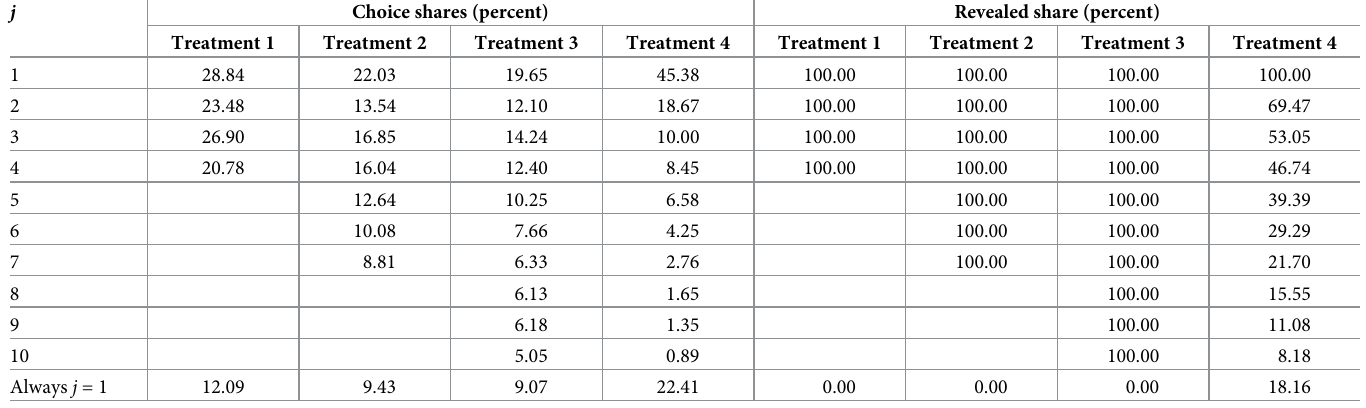
Table 3. Choice breakdown by